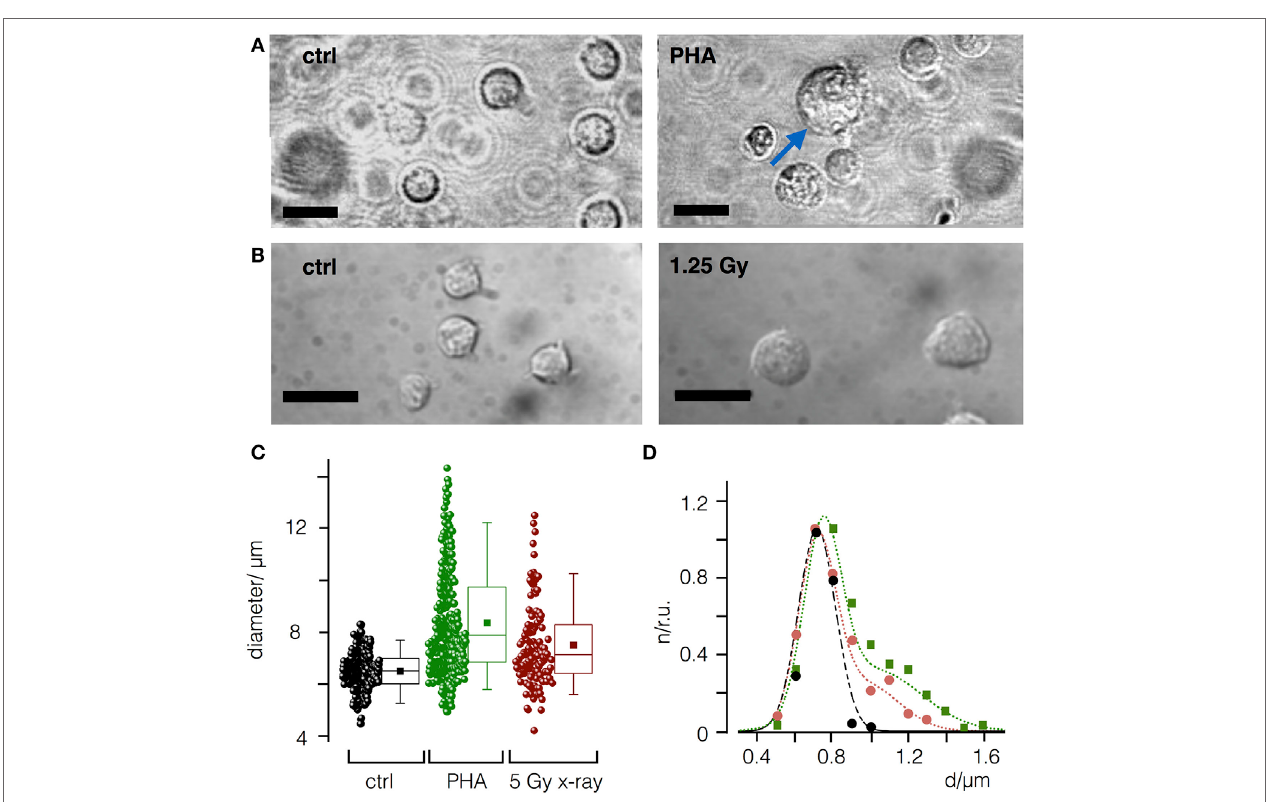
FigUre 2 | Mitogen phytohemagglutinin (PHA-L) and ionizing irradiation cause an increase in diameter of naïve peripheral blood leukcocytes (PBL). (a) Representative images of PBL before (control) and 48 h after treatment with PHA-L (7.2 µg/m). (B) Before and 48 h after irradiation with a dose of 5 Gy. Scale bars 10 µm. (c) Cell diameters of PBL control cells (ctrl) or PBL treated with PHA-L or 5 Gy. Each data point represents a single PBL with mean (filled square) and median value (line) as well as 25 and 75 percentile of data; whiskers indicate 5 and 95 limits of data. (D) Size distribution histogram of ctrl (black) and of cells treated with PHA-L (green) or 5 Gy (red) from (B) . Distribution was normalized to maximal value for each condition and fitted with single Gauss distribution (control, black line) or the sum of two Gaussians for T-cell activator (green line) or X-ray (red line) treated